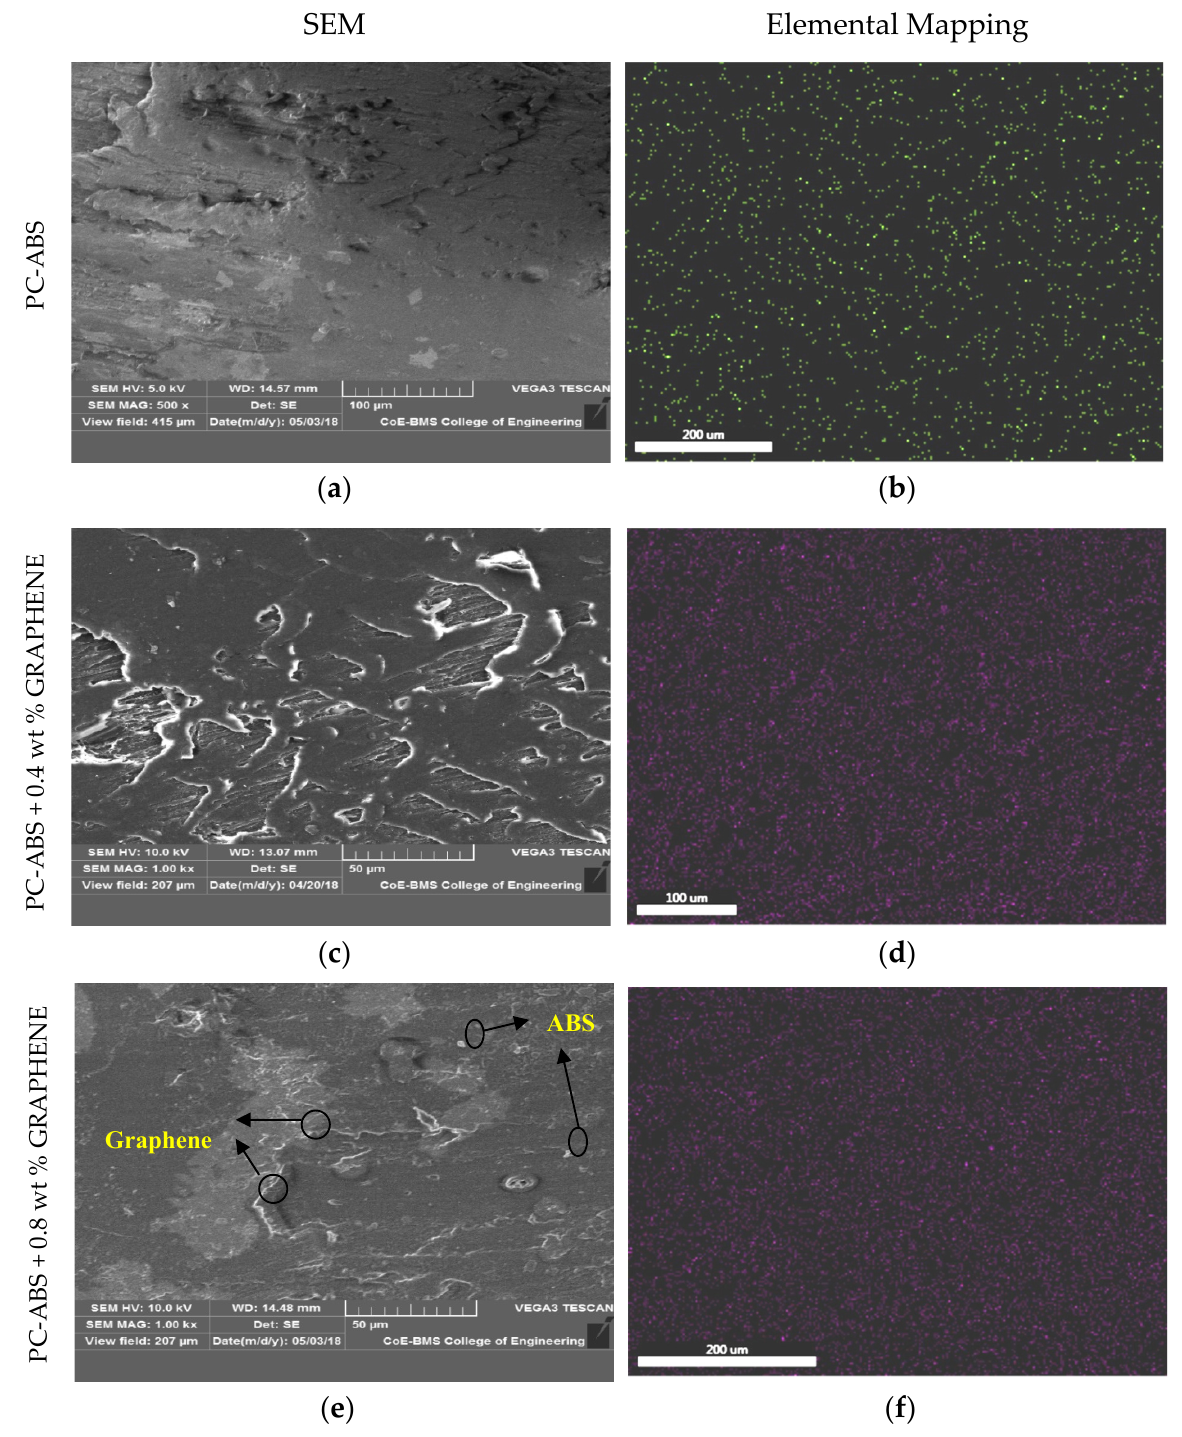
Figure 9. SEM and elemental mapping of ( a , b )PC-ABS, ( c , d )PC-ABS+0.4 wt % graphene, and ( e , f )PC-ABS+0.8 wt % graphene.